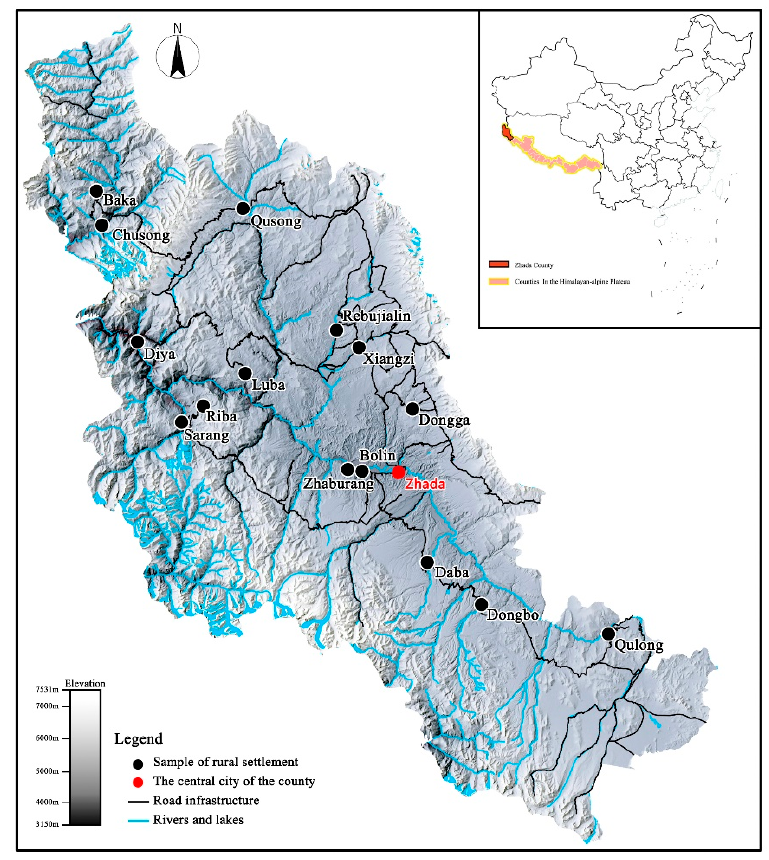
Figure 1. Sample distribution of 15 rural settlements in Zhada County.